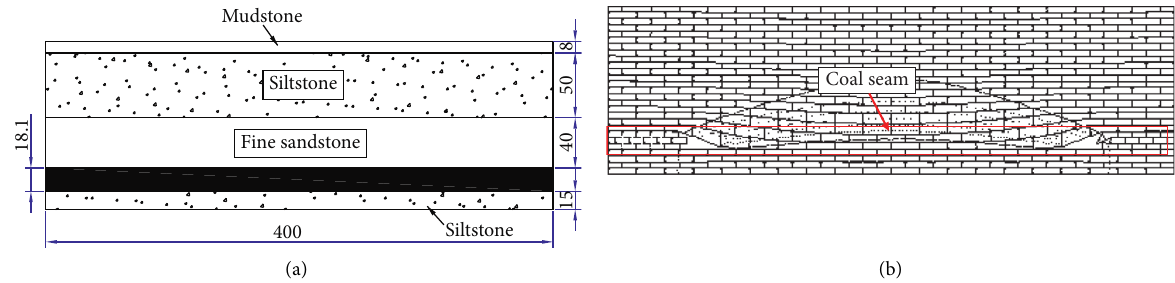
Figure 6: Model drawing of simultaneous mining of all coal seams. (a) CAD design drawing. (b) UDEC model